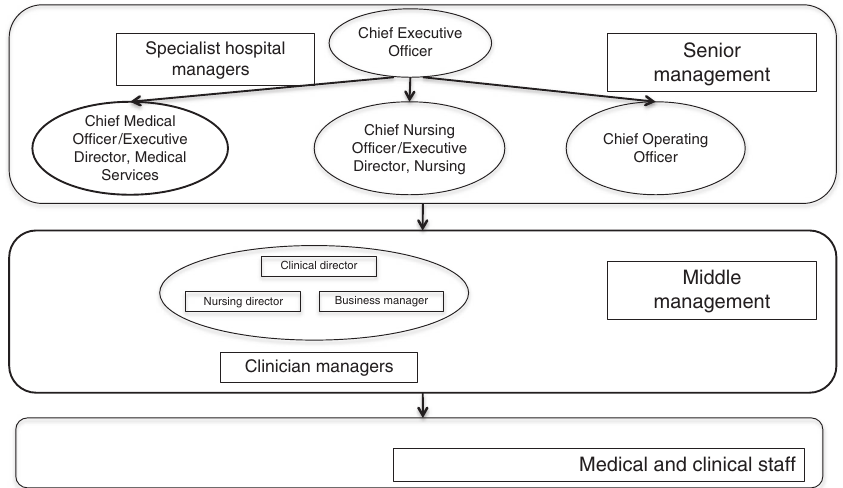
Figure 2. Medical managers in senior and middle